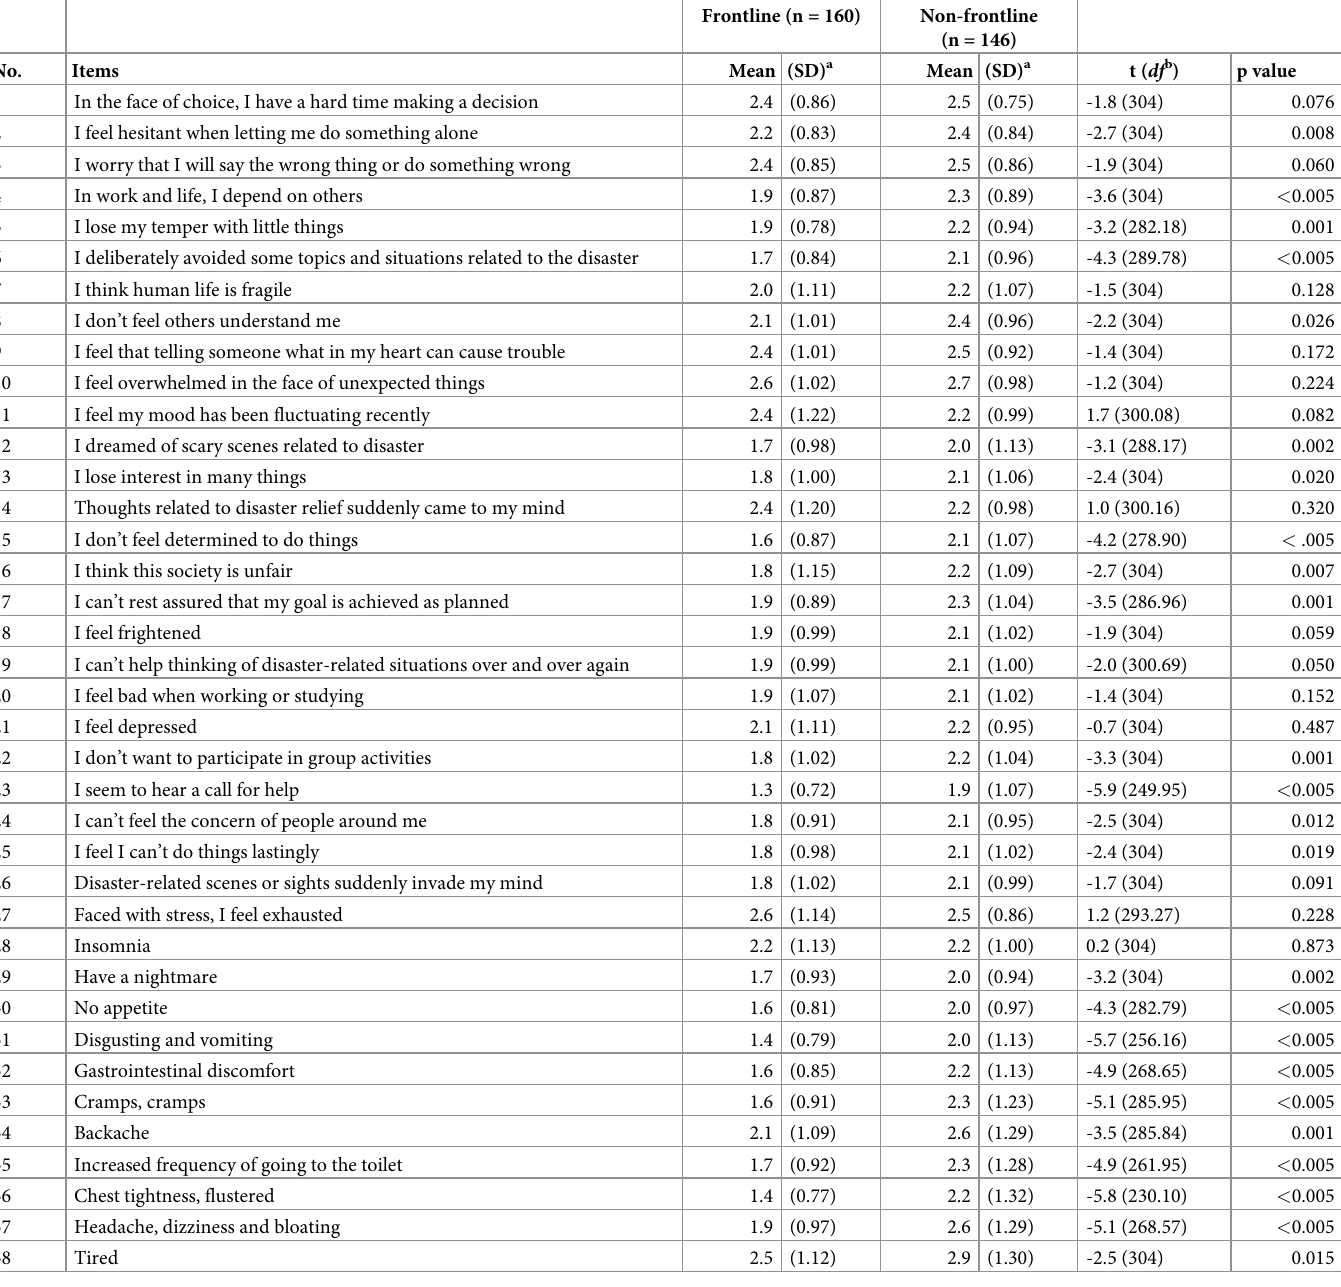
Table 2. Vicarious Traumatization Questionnaire